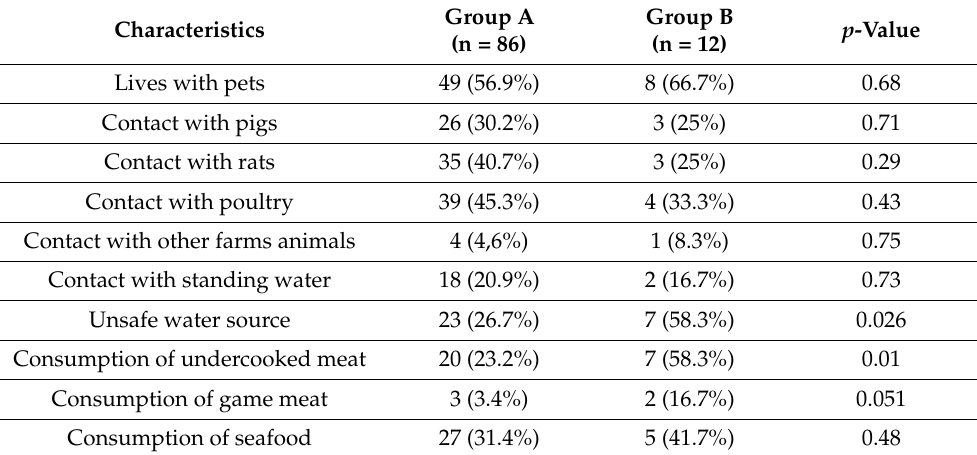
Table 2. Epidemiological characteristics of the